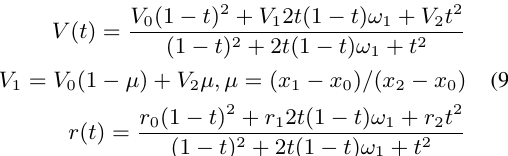
Figure 7: Orientation map construction for ”common red point”. Orientation map is build based on thickness map. b ( r b , o b ) - big maximum disc with center in point b, radius r b and orientation o b . s ( r s , o s ) - small maximum disc with center in point s, radius r s and orientation o s .